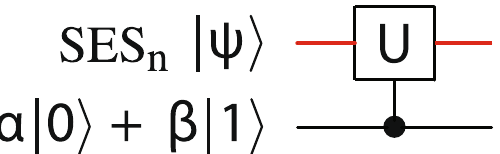
Figure 3. Controlled unitary operation. The red upper line is an n -qubit SES register, the lower line is the ancilla